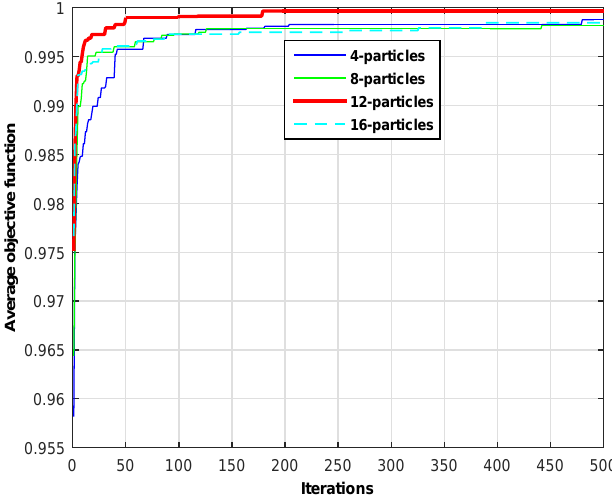
Figure 5. Average objective function for the low traffic scenario.